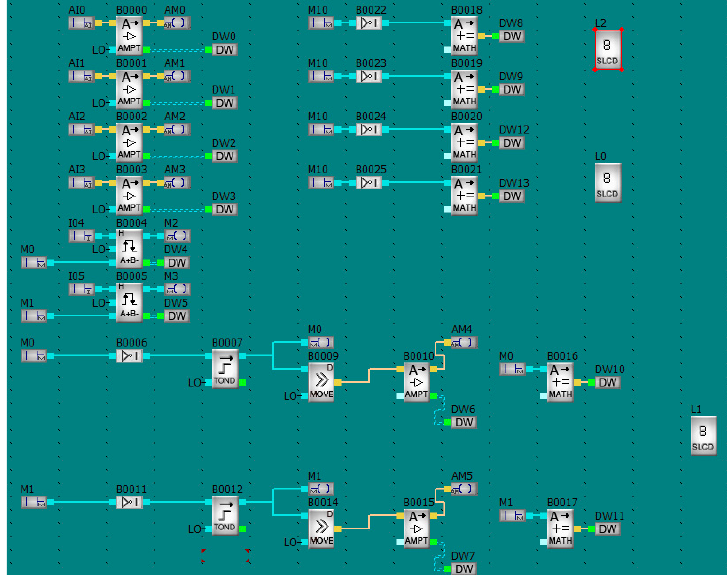
Figure 6. The PLC Program.